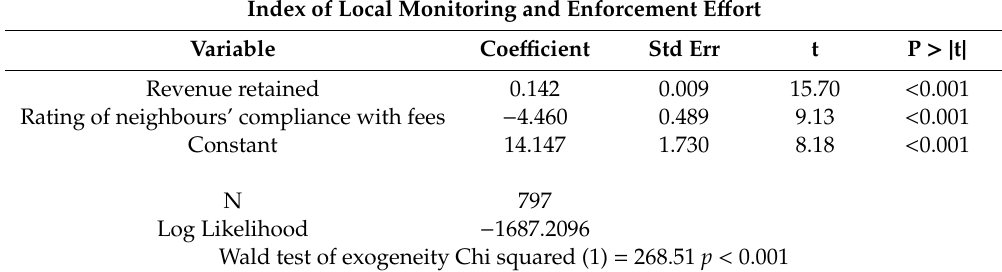
Table 1. 2SLS Tobit regression of index of perceived local monitoring and enforcement e ff ort against revenues retained locally and the rating of neighbours’ compliance with paying